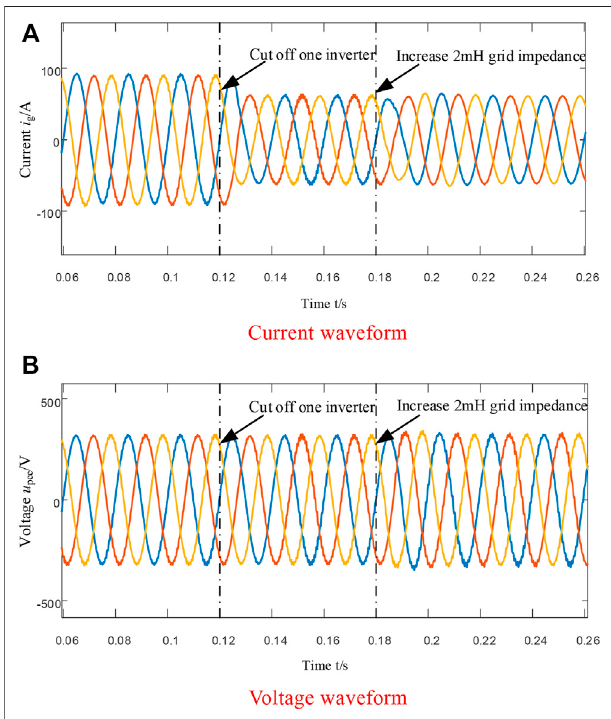
FIGURE 19 | Voltage and current waveform in dynamic